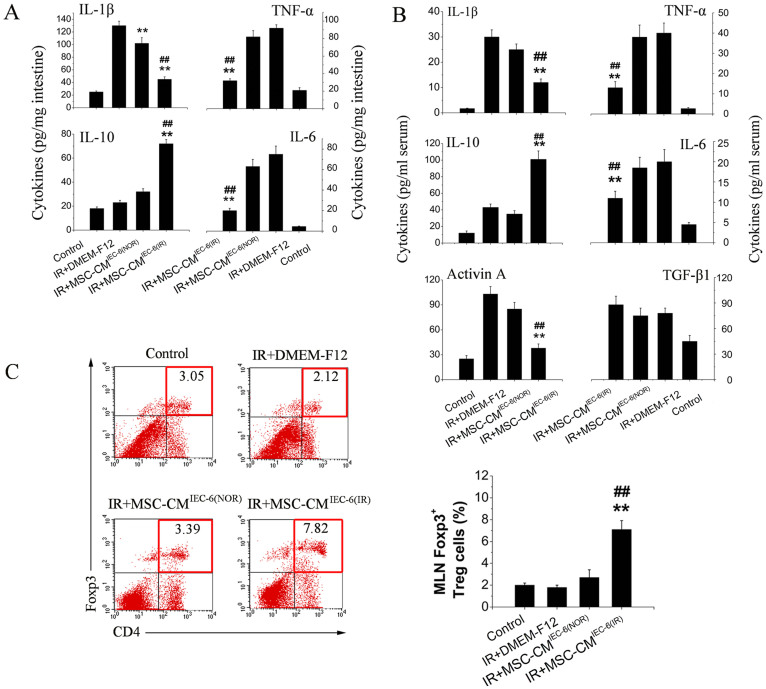
MSC-CMIEC-6(IR) down-regulates radiation-induced inflammatory responses at systemic and musocal level.(A) The levels of pro/anti-inflammatory cytokines in jejunal protein extracts 3 days after radiation were determined by enzyme-linked immunosorbent assay (ELISA). n = 4 rats/group. **, P < 0.05 versus IR + DMEM-F12, ##, P < 0.05 versus IR + MSC-CMIEC-6(NOR). (B) ELISA assays for serum pro/anti-inflammatory cytokines in rats of the 4 treatment groups are shown. Serum samples were collected 3 days after radiation. n = 4 rats/group, **, P < 0.05 versus IR + DMEM-F12, ##, P < 0.05 versus IR + MSC-CMIEC-6(NOR). (C) The percentages of CD4+Foxp3+ Treg cells in the CD4+ population of mesenteric lymph nodes (MLNs) were determined by flow cytometry (4–5 rats/group). Tissue samples were collected 3 days after radiation. **, P < 0.05 versus IR + DMEM-F12, ##, P < 0.05 versus IR + MSC-CMIEC-6(NOR).